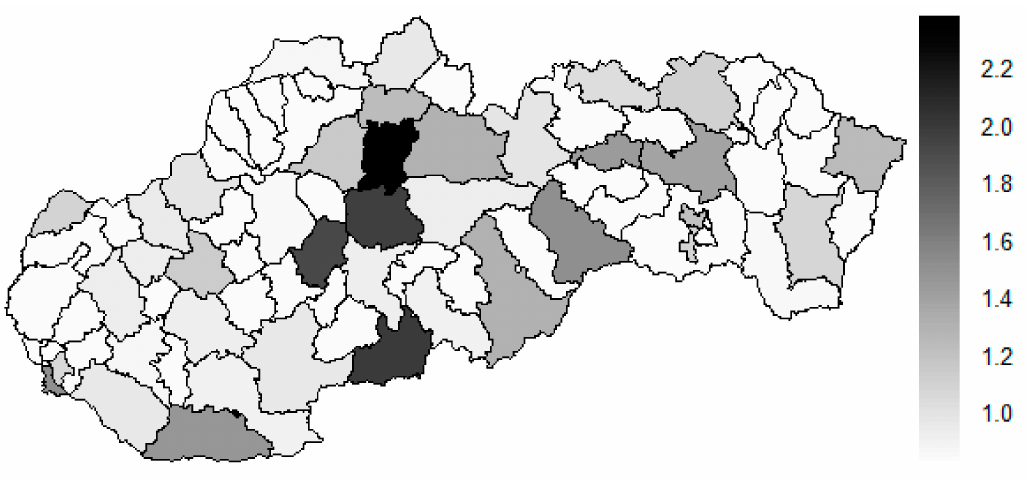
Figure 10. Modified medical equipment similarity map of the districts in the year 2008. Source: own elaboration by the authors.